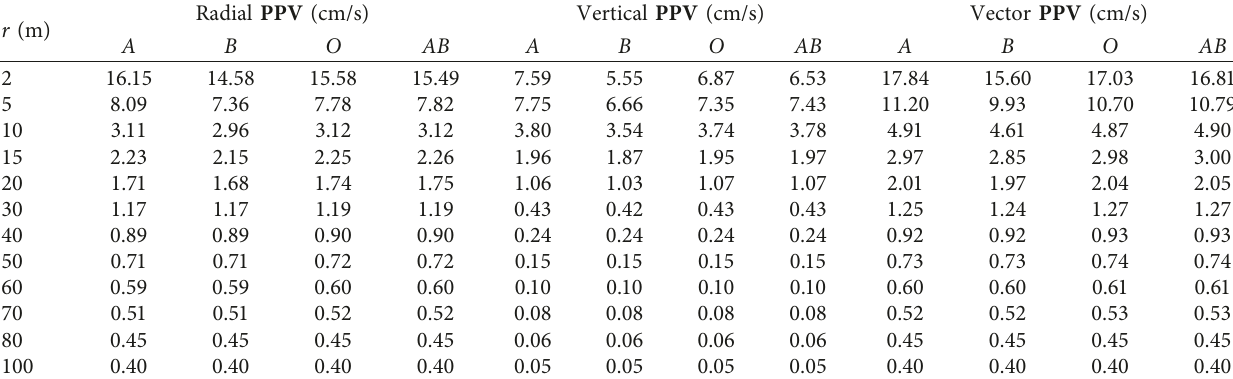
Table 2: Computational PPV s observed along the radial direction of the cylindrical charge.